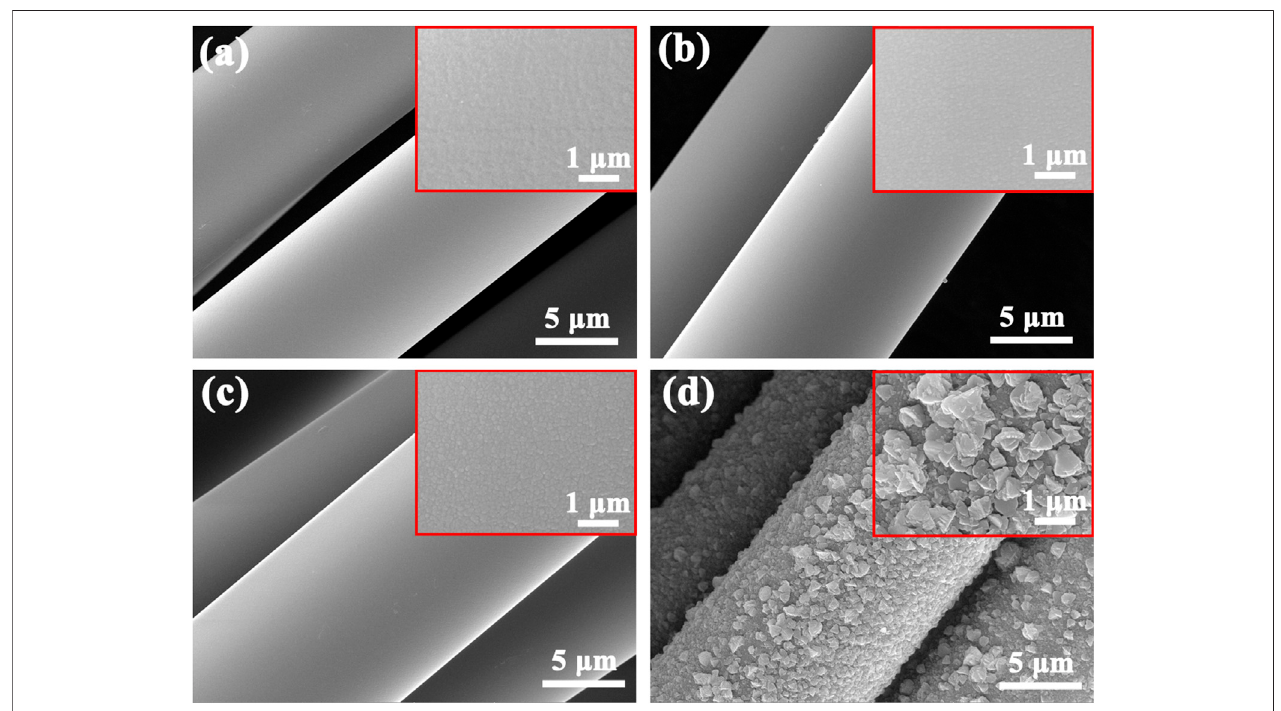
FIGURE 4 | SEM micrographs of SiCN fi bers after annealing at different temperatures: SCN-1,300 (A) , SCN-1,400 (B) , SCN-1,500 (C) and SCN-1,600 (D) .